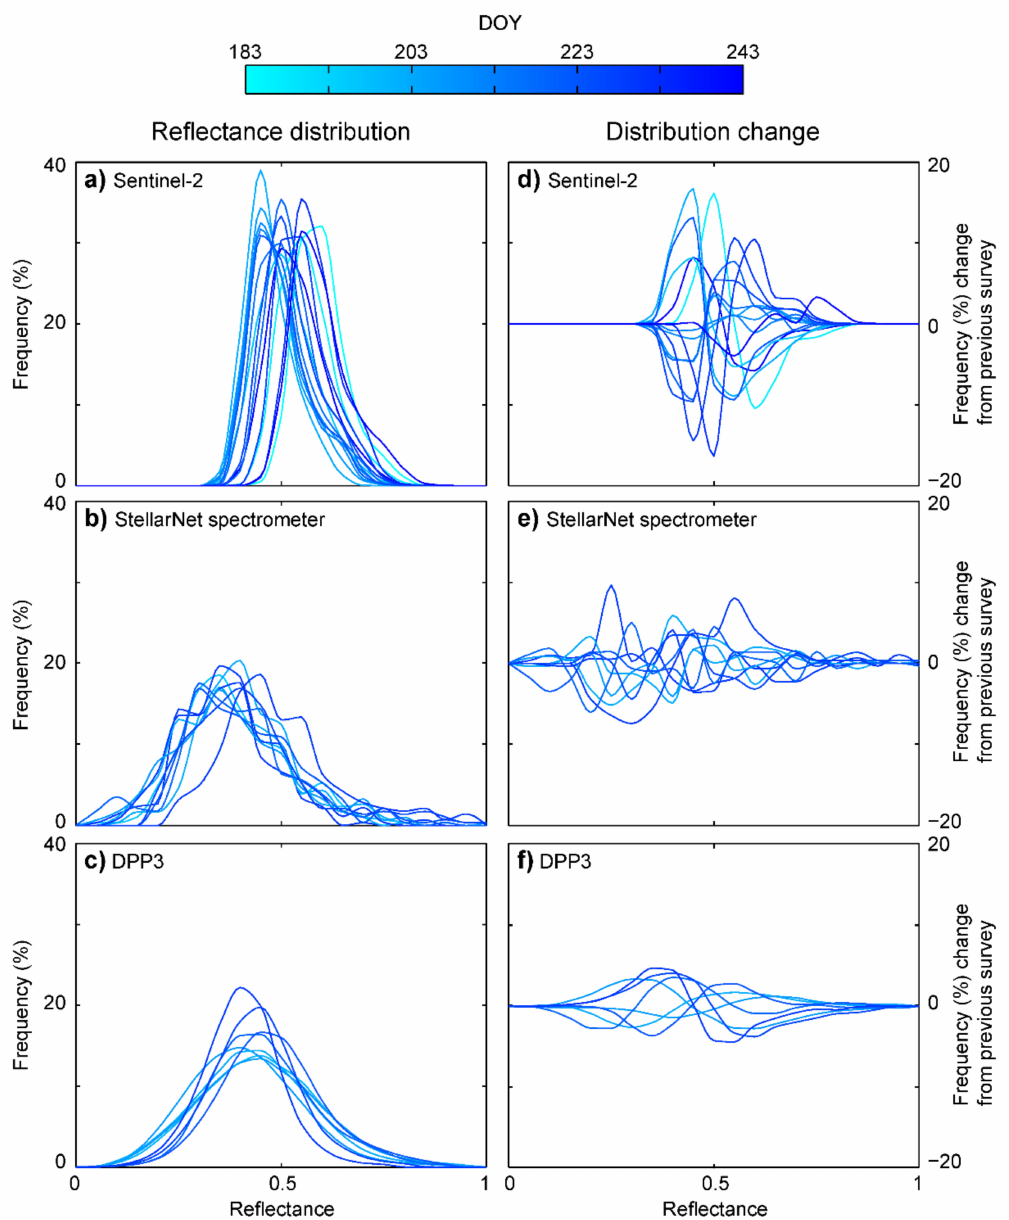
Figure 3. Reflectance distribution frequency plots for ( a ) Sentinel-2, ( b ) ground-based SNBW spec- trometer surveys, and ( c ) DPP3 derived spatial datasets; reflectance is grouped into 0.05 (5%) bins. Equivalent plots of distribution change between each of the platform surveys are given in ( d – f ), again with a 5% reflectance bin size. The distributions for the ground-based reflectance surveys exhibit a less smooth form arising from the categorization of the reduced number of observations ( n ≈ 300) compared to the image-based observations ( n ≥